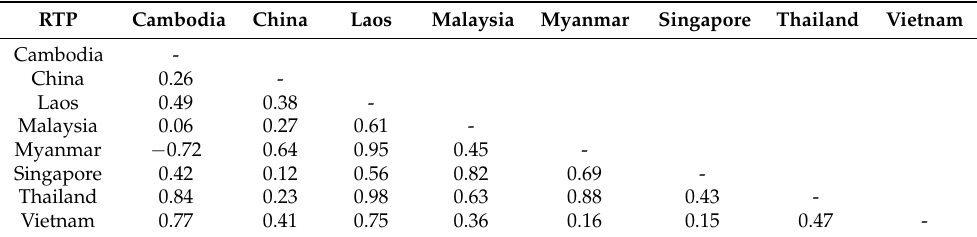
Table 5. RTP index for countries in the China–Indochina Peninsula Economic Corridor (CICPEC). RTP Cambodia